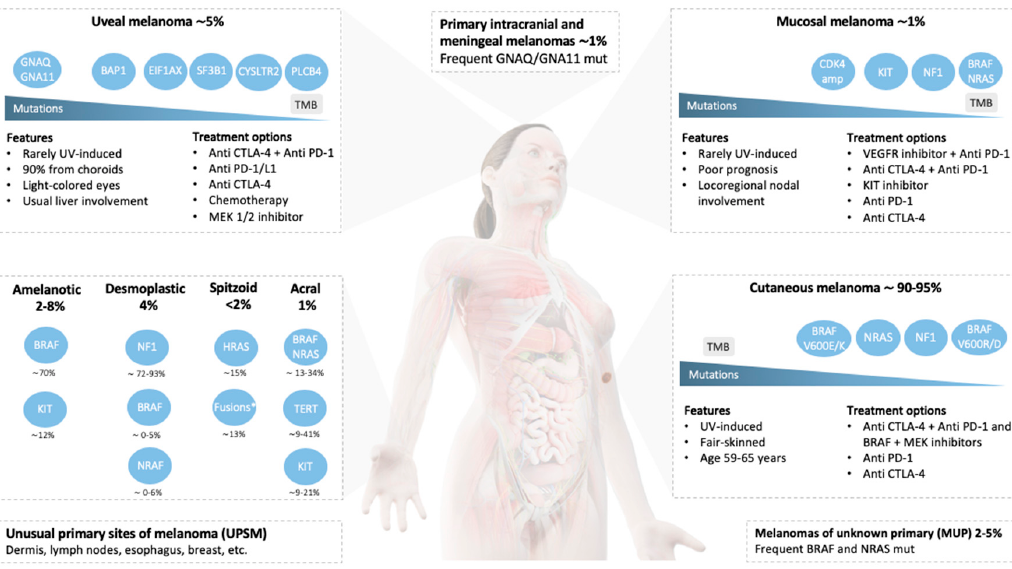
Figure 1. Schematic summary of the most relevant mutations, key features, and treatment options of rare melanomas. For each subtype, mutations are ordered by their prevalence. Main treatment strategies were ordered according to the decreasing efficacy outcomes, including the overall response rate, progression-free survival, and overall survival. Abbreviations: TMB, tumor mutational burden; UV, ultraviolet radiation; Mut, mutation; Amp, amplification; KIT, receptor tyrosine kinase (c-Kit); VEGFR, vascular endothelial growth factor receptor. *Fusion kinases involving ALK, ROS1, NTRK1, NTRK3, MET, RET, BRAF, and MAP3K8.